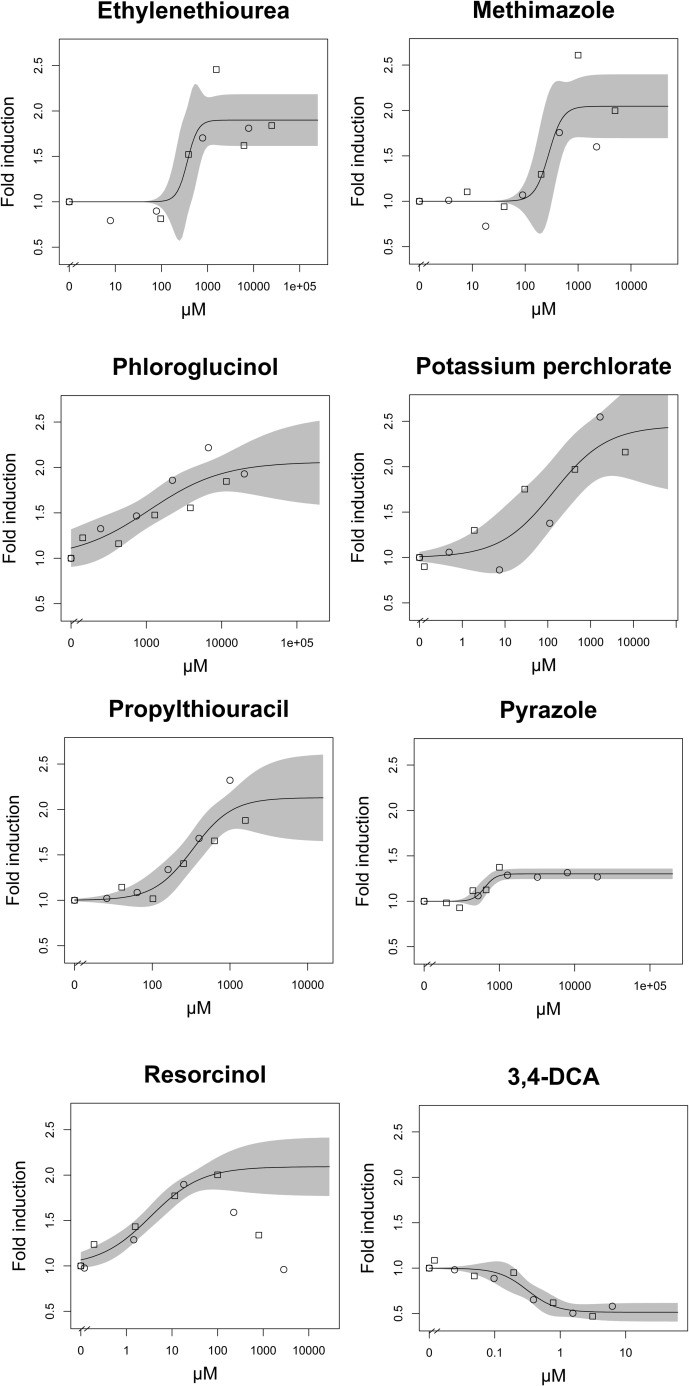
Concentration-response curves for induction of fluorescence in transgenic zebrafish embryos harboring a copy of the reporter gene mCherry and the regulatory region of thyroglobulin.Zebrafish embryos were exposed to known goitrogenic compounds and the negative control 3,4-dichloroaniline (3,4-DCA). The two different symbols represent two different replicates. Each replicate value represents the mean of at least 10 embryos analysed per concentration. The grey shaded zone represent 95% confidence intervals.